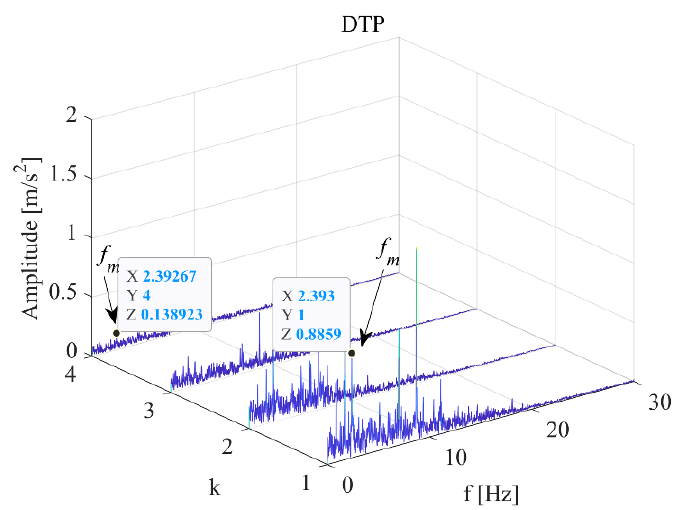
Figure 4. Vibration demodulation diagram of main engine when elevator speed is 1 m/s.